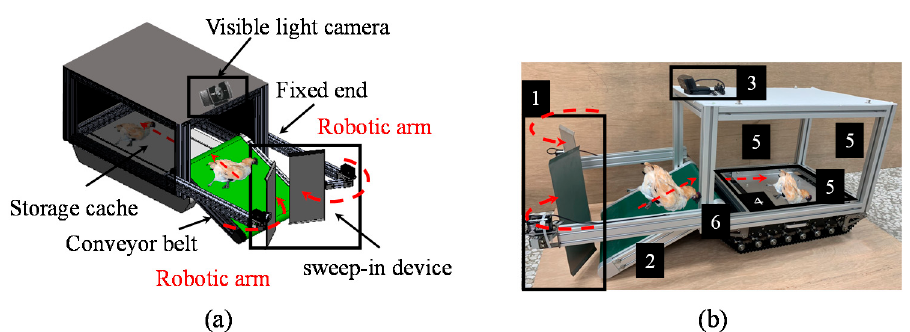
Figure 2. Design of the small chicken removal system: ( a ) schematic and ( b ) experimental setup. (1) Two stainless steel plates for rotational movement, (2) conveyor belt for single-axis movement, (3) visible light camera for capturing images, (4) storage cache for storing dead chickens, (5) three transparent acrylic sheets for the enclosed space, and (6) tracked vehicle. Table 1. Components and systems of the designed chicken removal system.